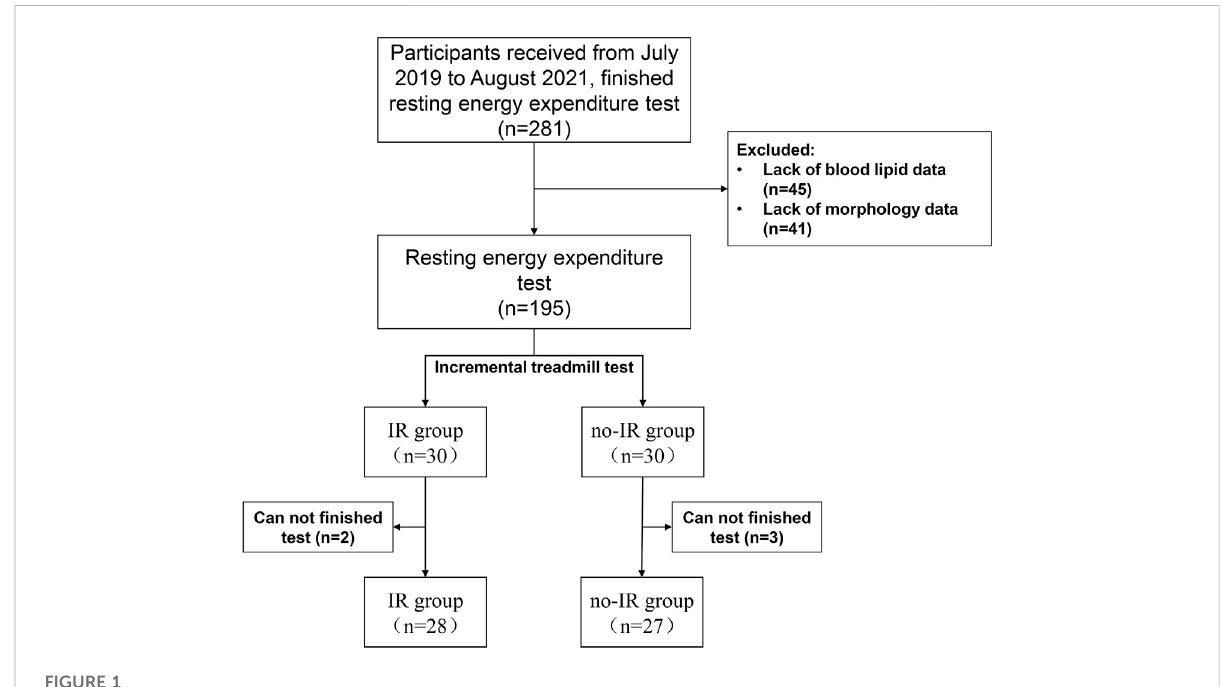
FIGURE 1 Participants screened fl